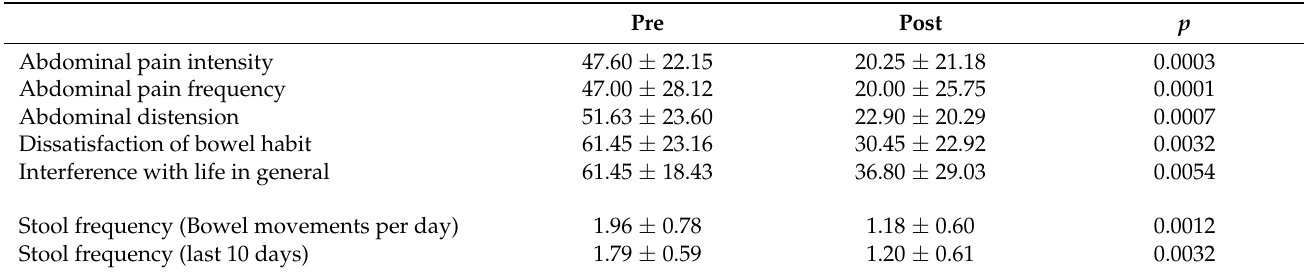
Table 2. The single items and stool frequency of IBS Severity Scoring System of IBS-D patients recorded before and after low FODMAPs diet.